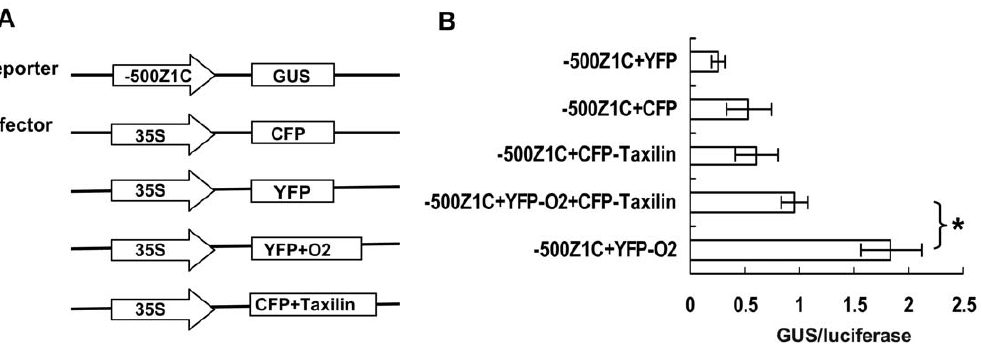
Figure 6. ZmTaxilin can repress the transcriptional activity of ZmO2. ( A ) Structure of effecter and reporters. ( B ) GUS/luciferase values of different reporter and effecter combinations. The values are the averages with SD of three independent experiments, after normalisation to